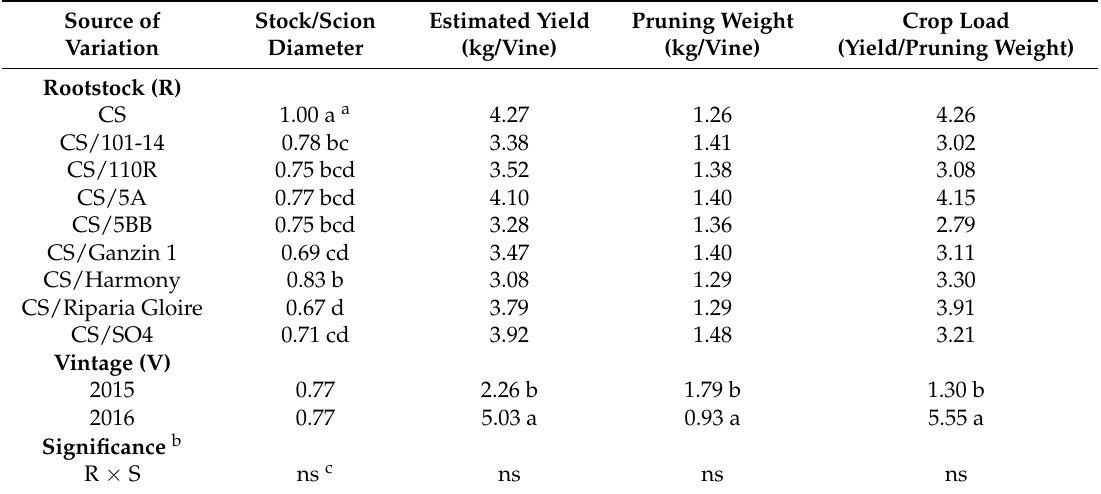
Table 1. Effects of rootstocks on vine growth parameters in two seasons